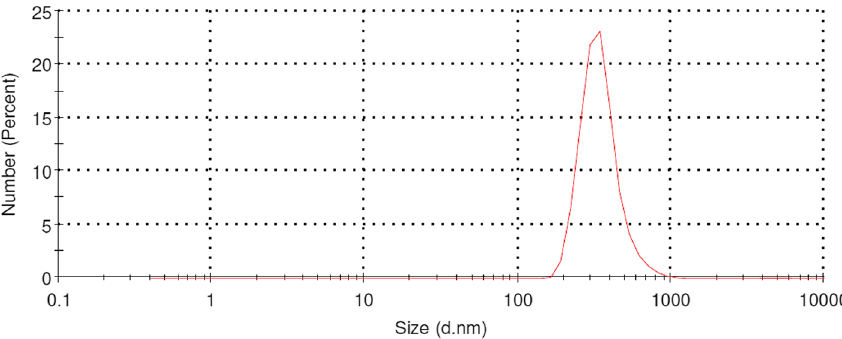
Figure 2. Particle size distribution of CuNP particles as measured by PSA. The mean size is 576 nm.